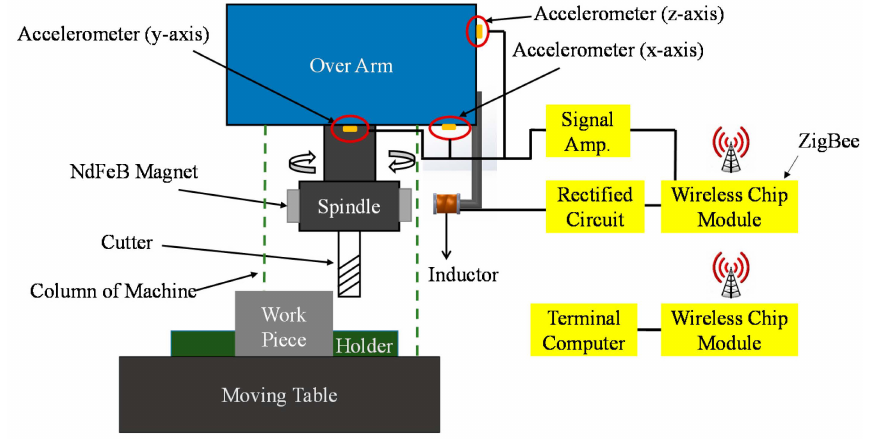
Figure 2. The front-view illustration of the testing setup (using the system to monitor milling-processes and cutter-wear/breakage